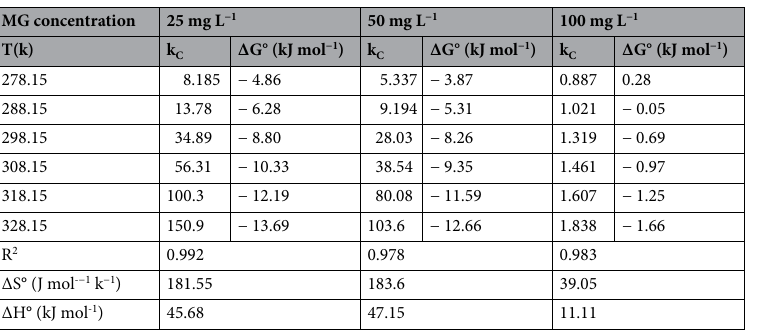
Table 6. Thermodynamic parameters for the adsorption of MG dye onto meso-CaAl 2 O 4 (volume = 50 mL, adsorbent mass = 8 mg, contact time = 15 min, and solution pH